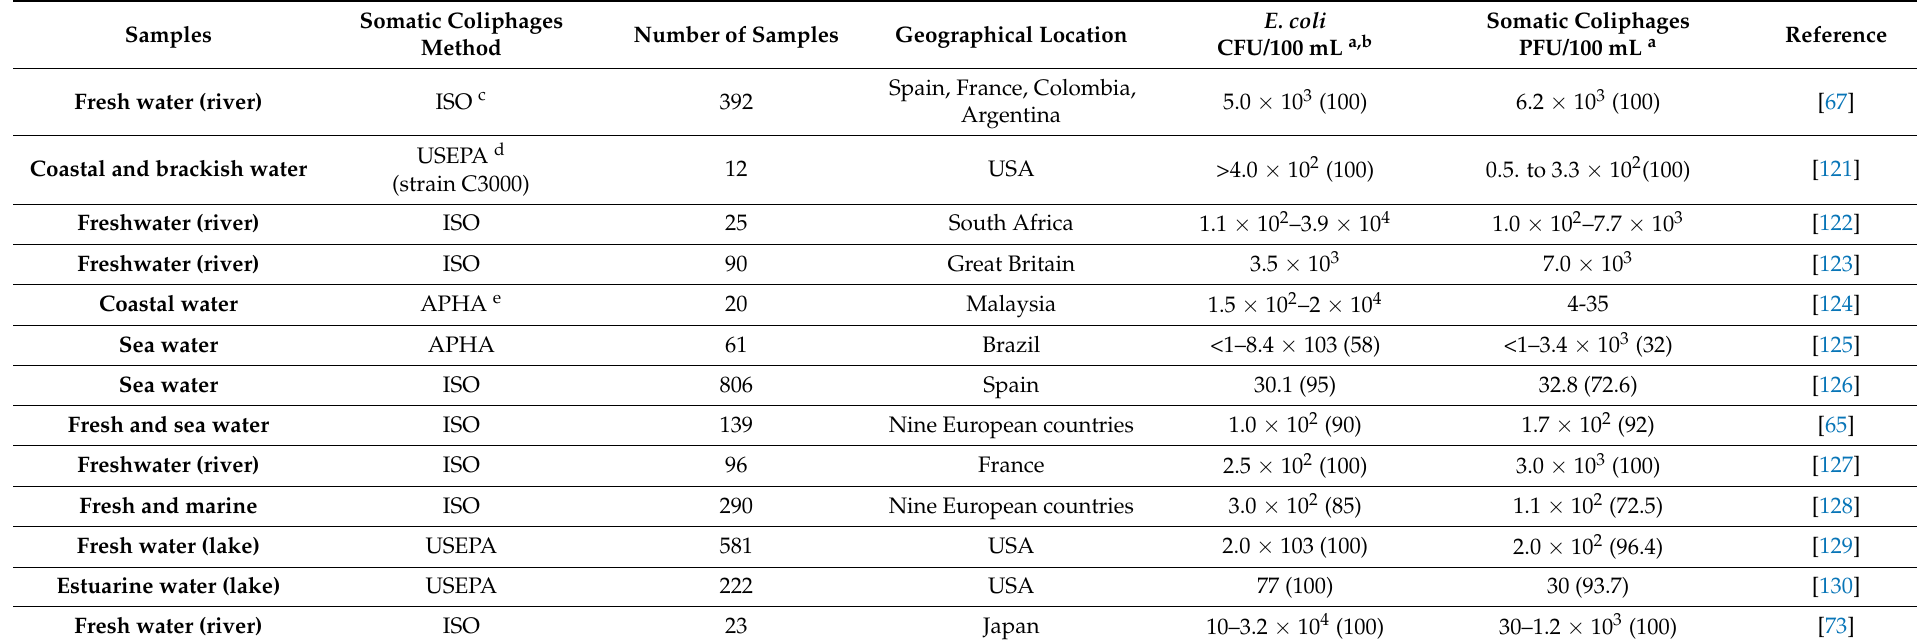
Table 1. Concentrations of E. coli /fecal coliforms and somatic coliphages in surface waters. a Values of indicator bacteria and somatic coliphages are expressed as intervals or geometric means. In brackets percentages of positive samples, b values in MPN or CFU detected by methods according to national regulations, c ISO 10705–2 [57], d USEPA Method 1602 [59], e standard methods for the examination of water and wastewater